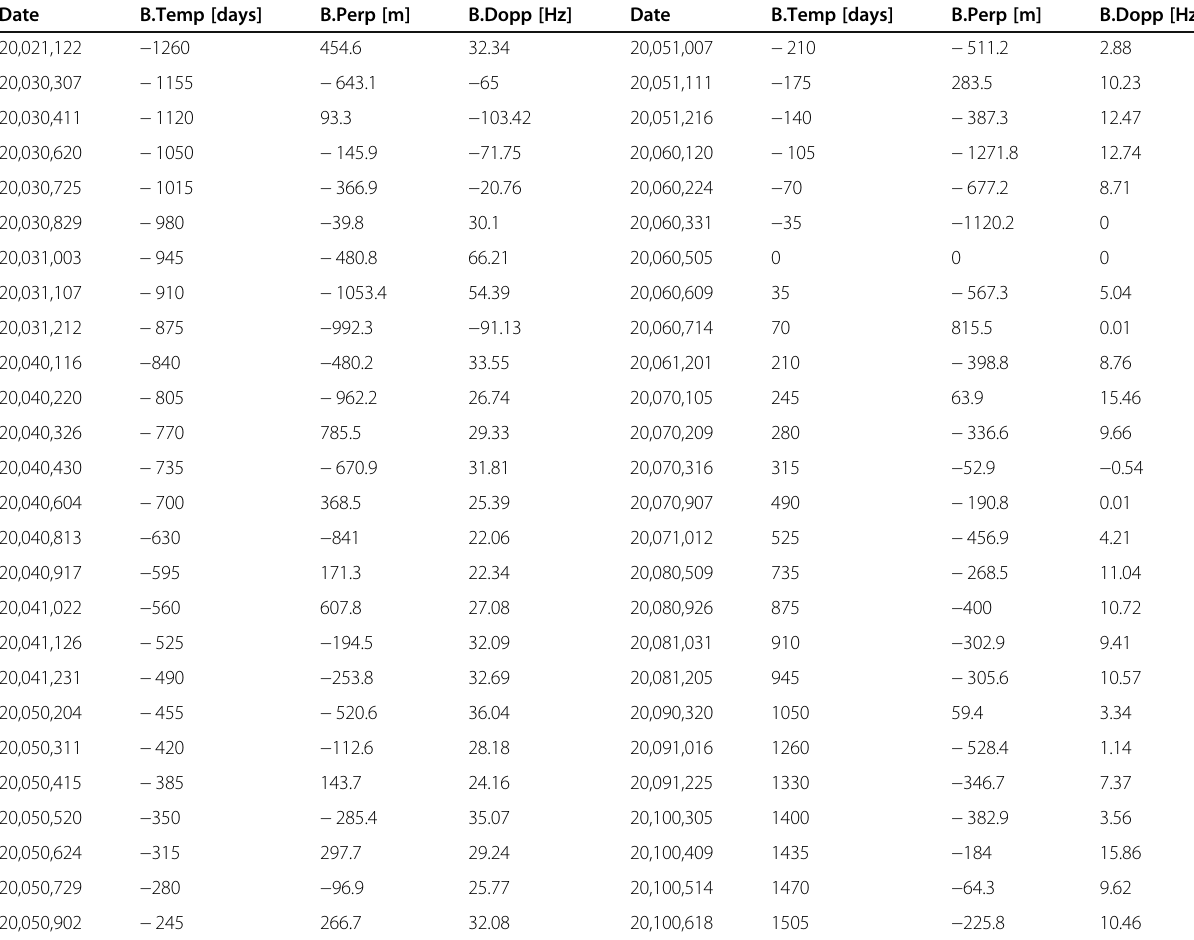
Table 2 Baseline information of ENVISAT-ASAR imageries